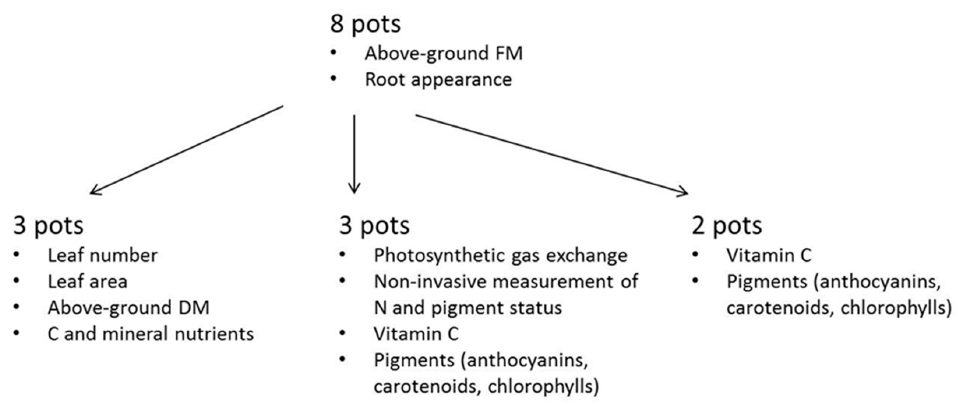
Figure 2. Parameters assessed at harvest of the arugula plants. Each pot contained 30 plants. FM = fresh mass, DM = dry mass.